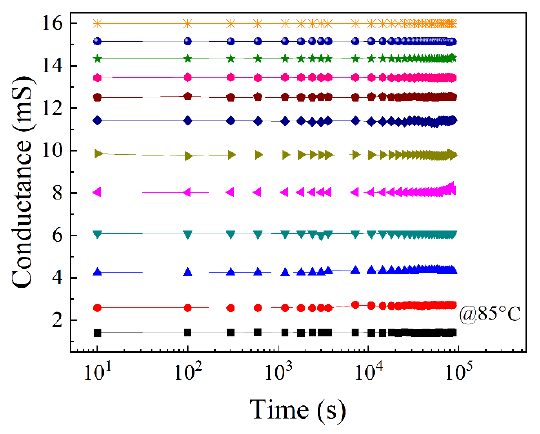
Figure 7. The retention test of all levels of resistance at 85 °C. From bottom to top, the conductance of the device after applying 1, 2, 5, 10, 20, 40, 70, 110, 160, 220, 300, and 400 set pulses.